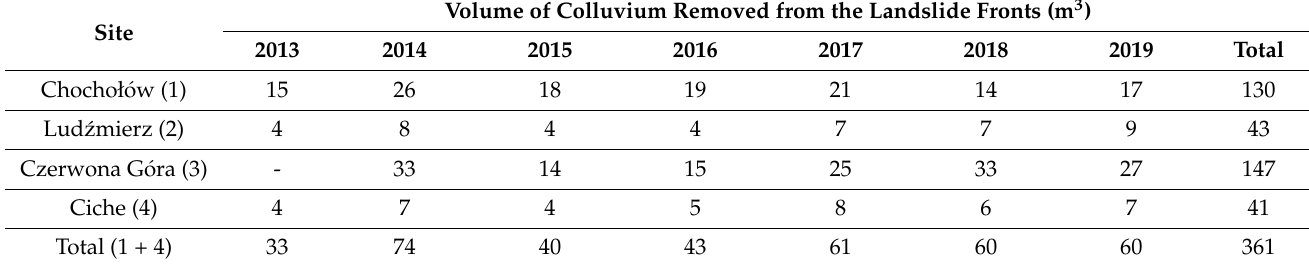
Table 2. Volumes of colluvium removed from the studies landslides in the period